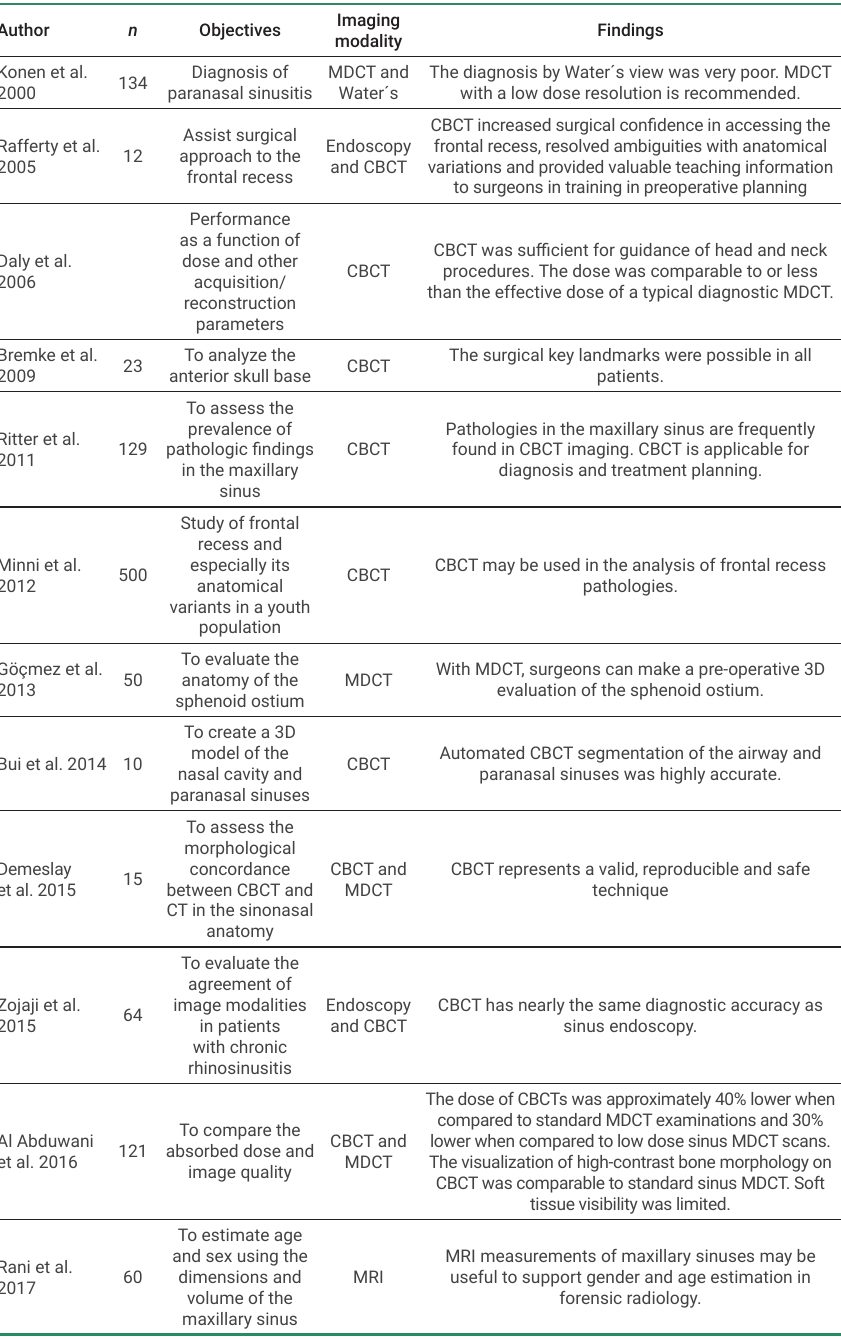
Table 1. Summary of literature review of diagnostic imaging modalities in paranasal